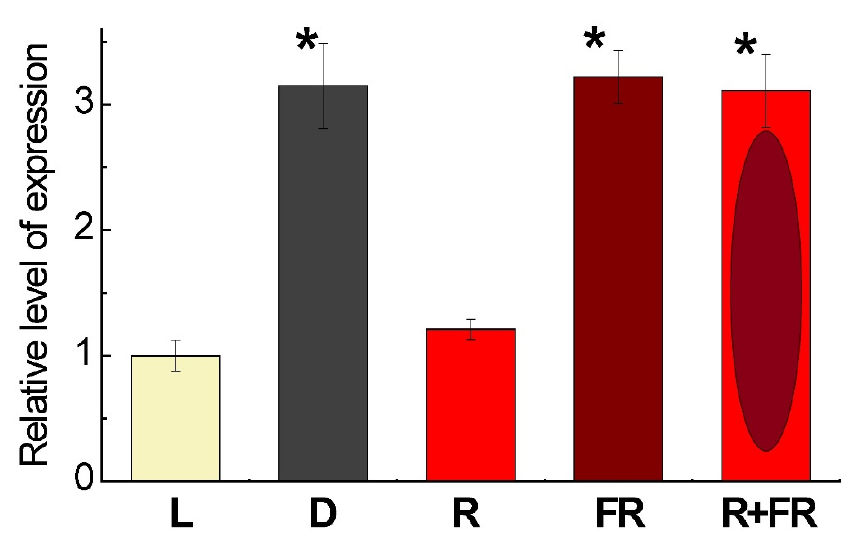
Figure 3. Relative level of Pif4 gene expression in maize leaves under different light conditions. Data are the means of three biological repeats ± SD. Asterisks indicate significant differences at p < 0.05. Abbreviations: L, plants illuminated with white light; D, plants kept in darkness; R, plants illuminated with red (660 nm) light; FR, plants illuminated with far-red (730 nm) light; R+FR, plants illuminated with red (660 nm) followed by far-red (730 nm) light.